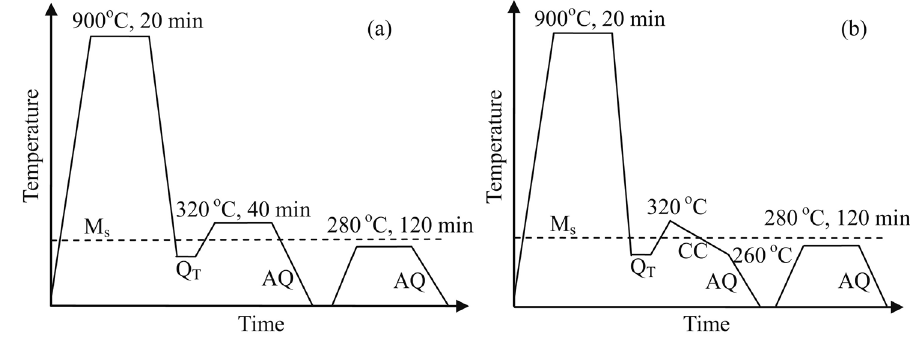
Figure 4. Different heat treatment processes used ( a ) Q&P process, ( b ) Q–DP process; QT: quenching temperature, CC: continuous cooling, AQ: air quenching. Extracted from reference [25]. Reproduced with permission from Elsevier, 2017.